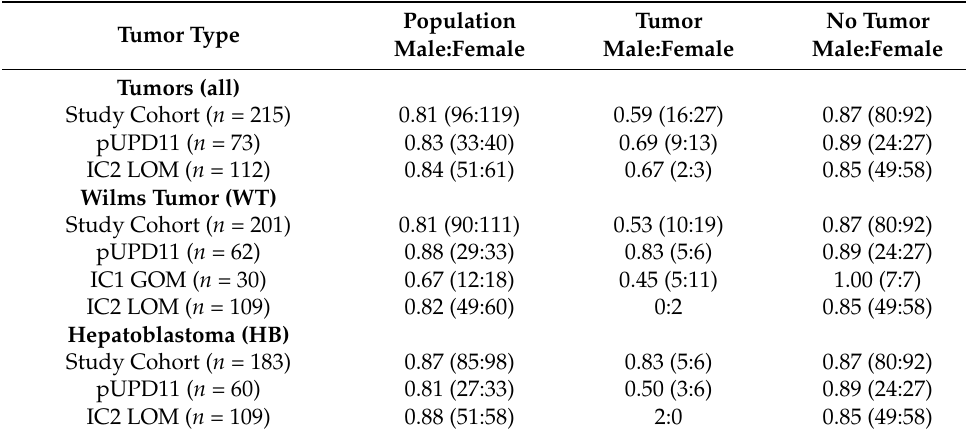
Table 2. Ratio of males to females with and without tumor development in study